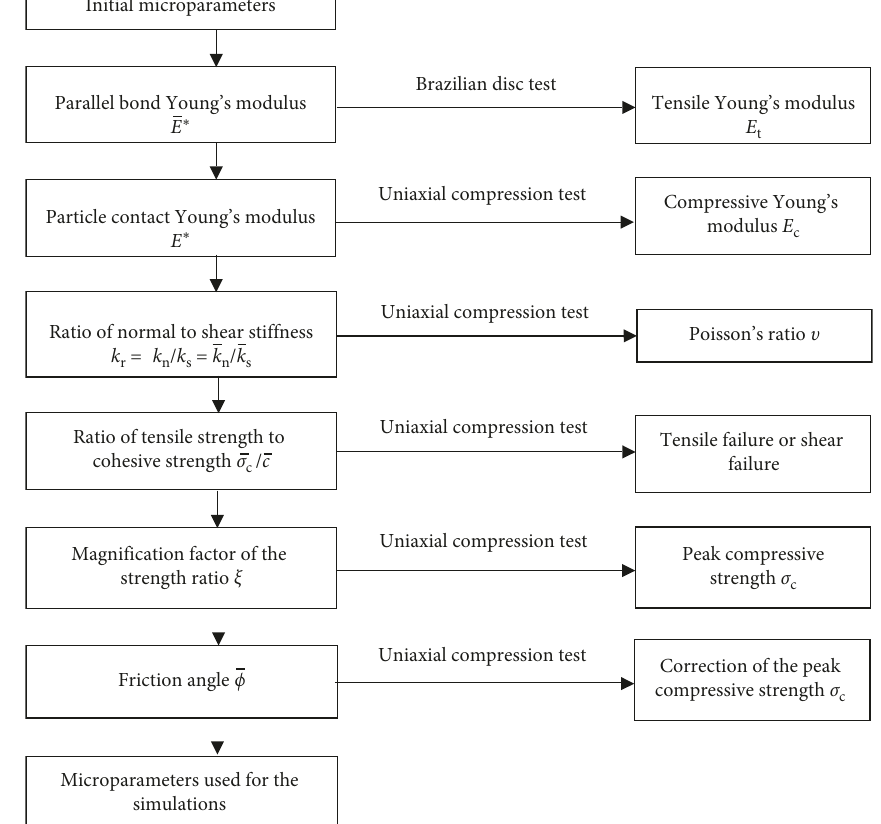
Figure 4: The calibration procedure and microparameters